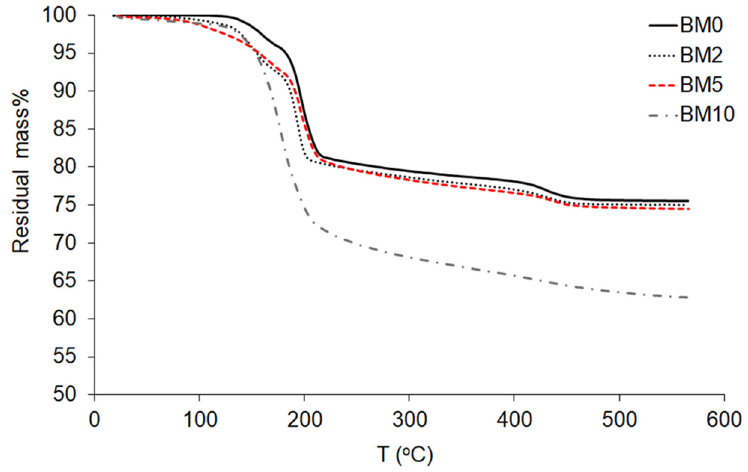
Figure 7. TG curves of Ca 1 − x Mg x HPO 4 ·nH 2 O compounds (BM0–BM10).